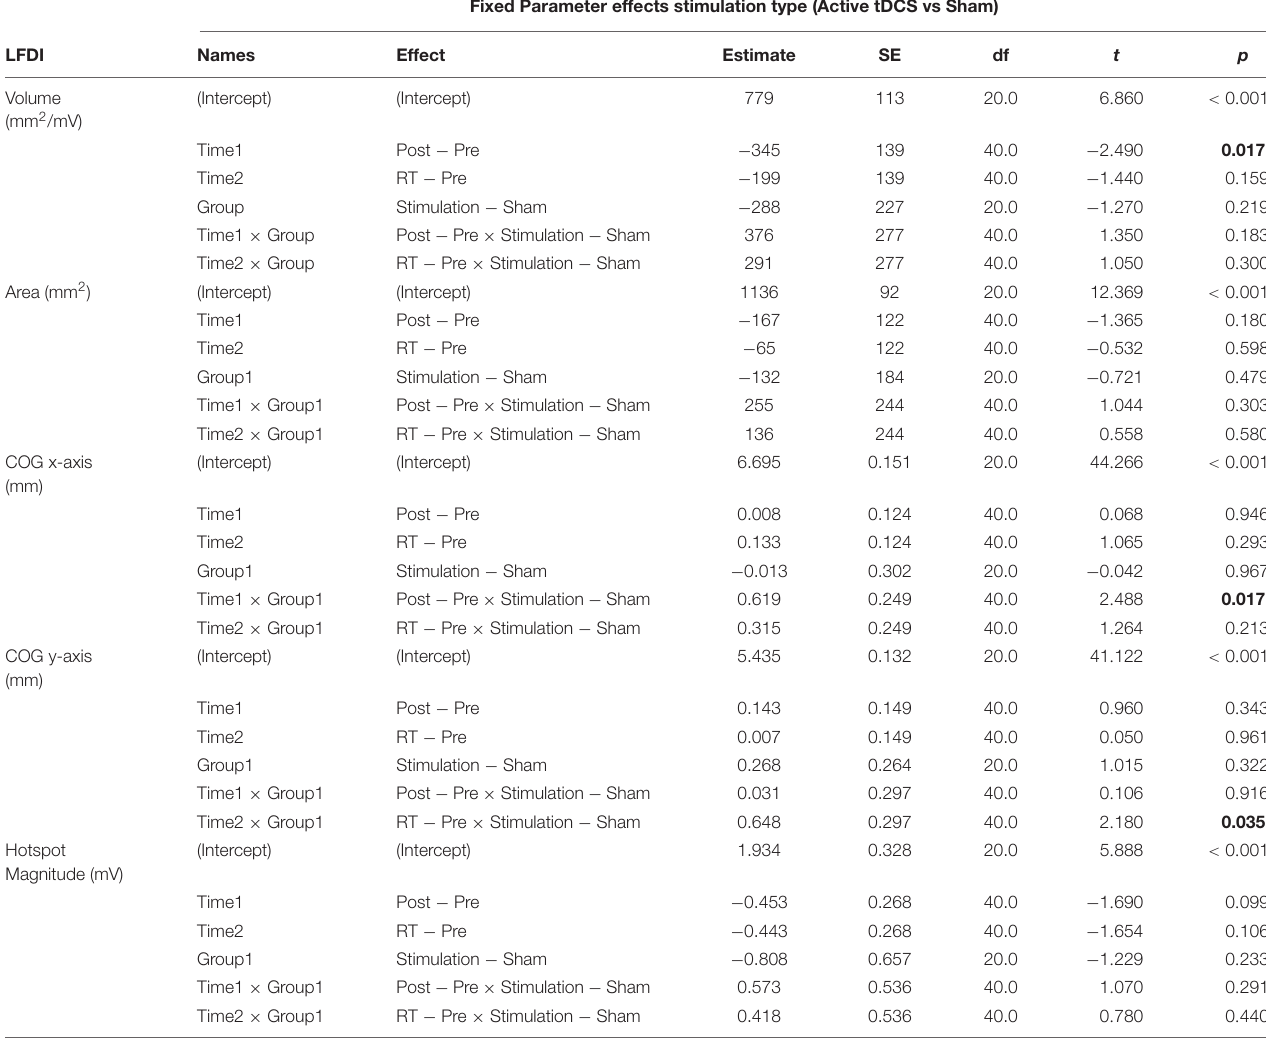
TABLE 3 | LFDI fixed parameters for motor map outcomes across Active and Sham stimulation (stimulation). Fixed Parameter effects stimulation type (Active tDCS vs